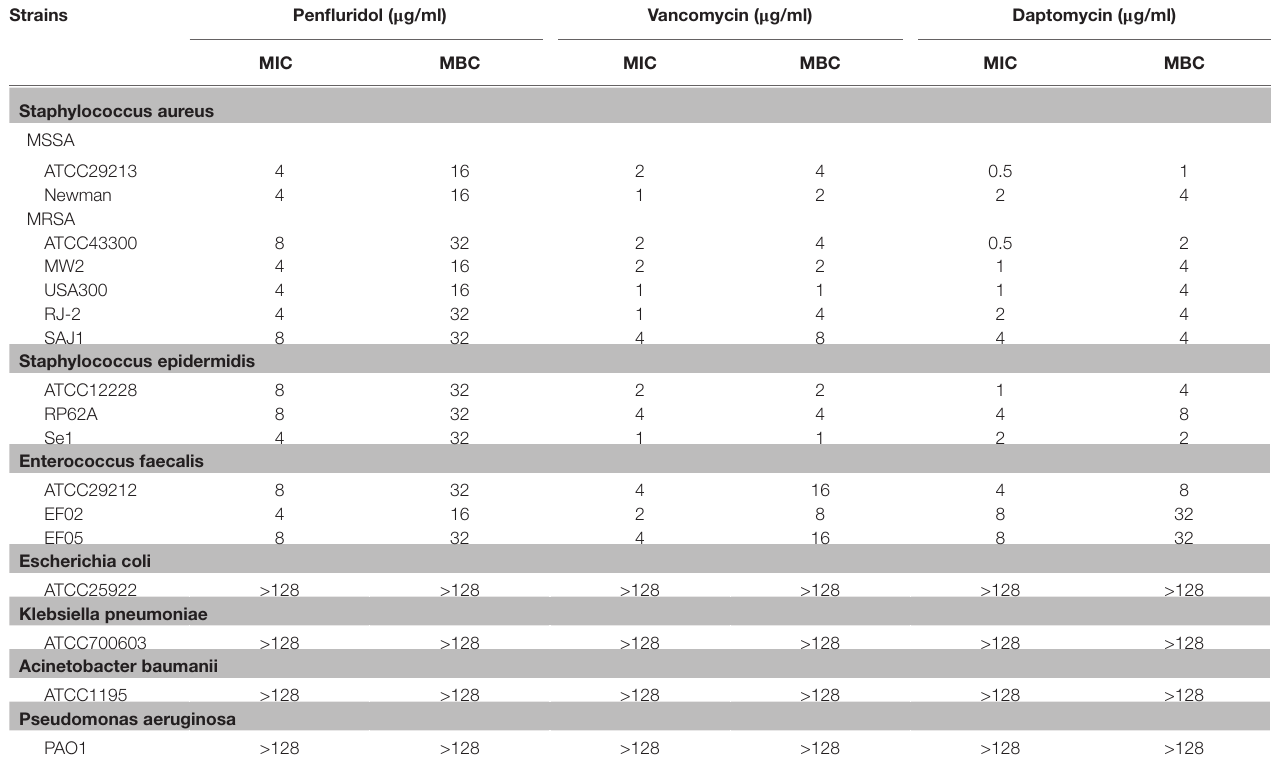
TABLE 1 | Minimum inhibitory concentration (MIC) and minimum bactericidal concentration (MBC) determination of PF, VAN, and daptomycin (DAP) toward bacterial strains. Strains